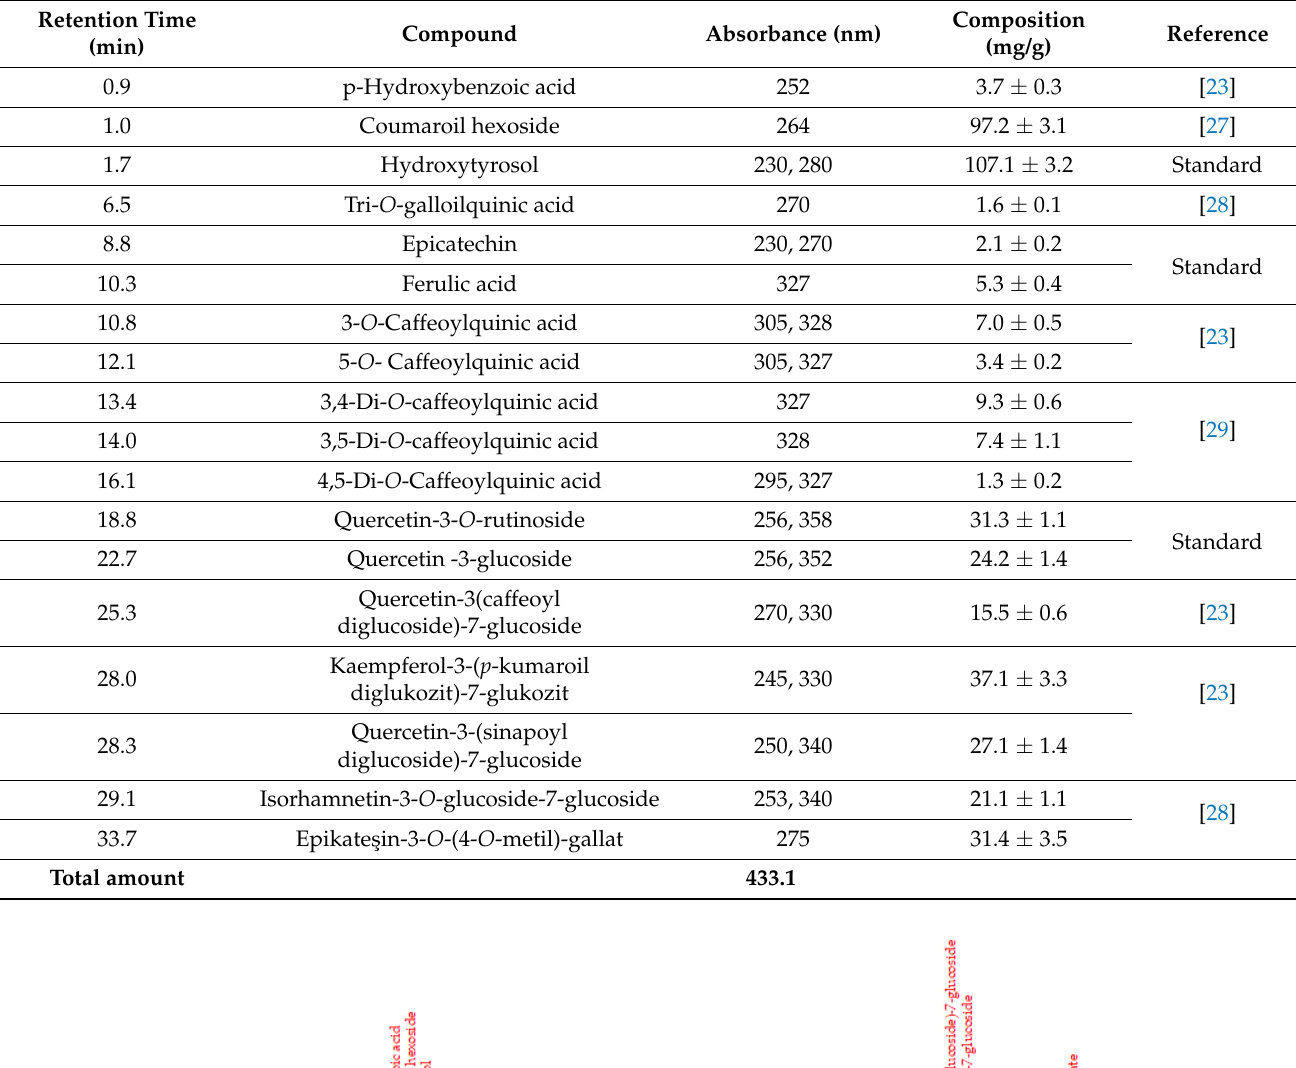
Table 1. Identification and composition of the polyphenolic profile of the methanol extract prepared from the leaves of M. neglecta using HPLC-DAD.